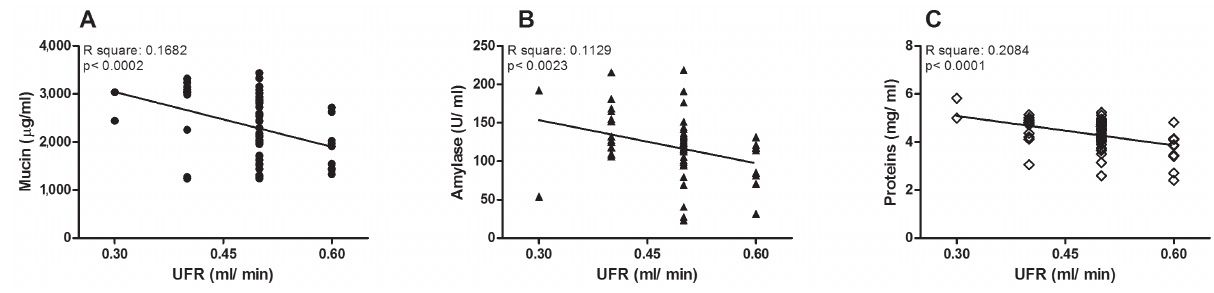
Figure 4- Pearson’s correlation analysis between mucin (A), amylase (B) and proteins (C) and salivary unstimulated flow rate (UFR) in the entire subjects